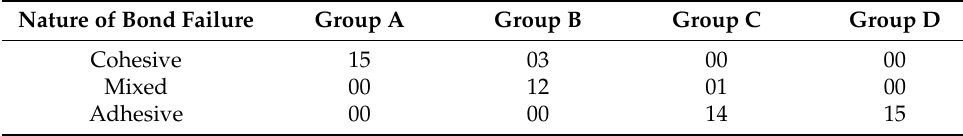
Table 4. Type of bond failure between the analyzed